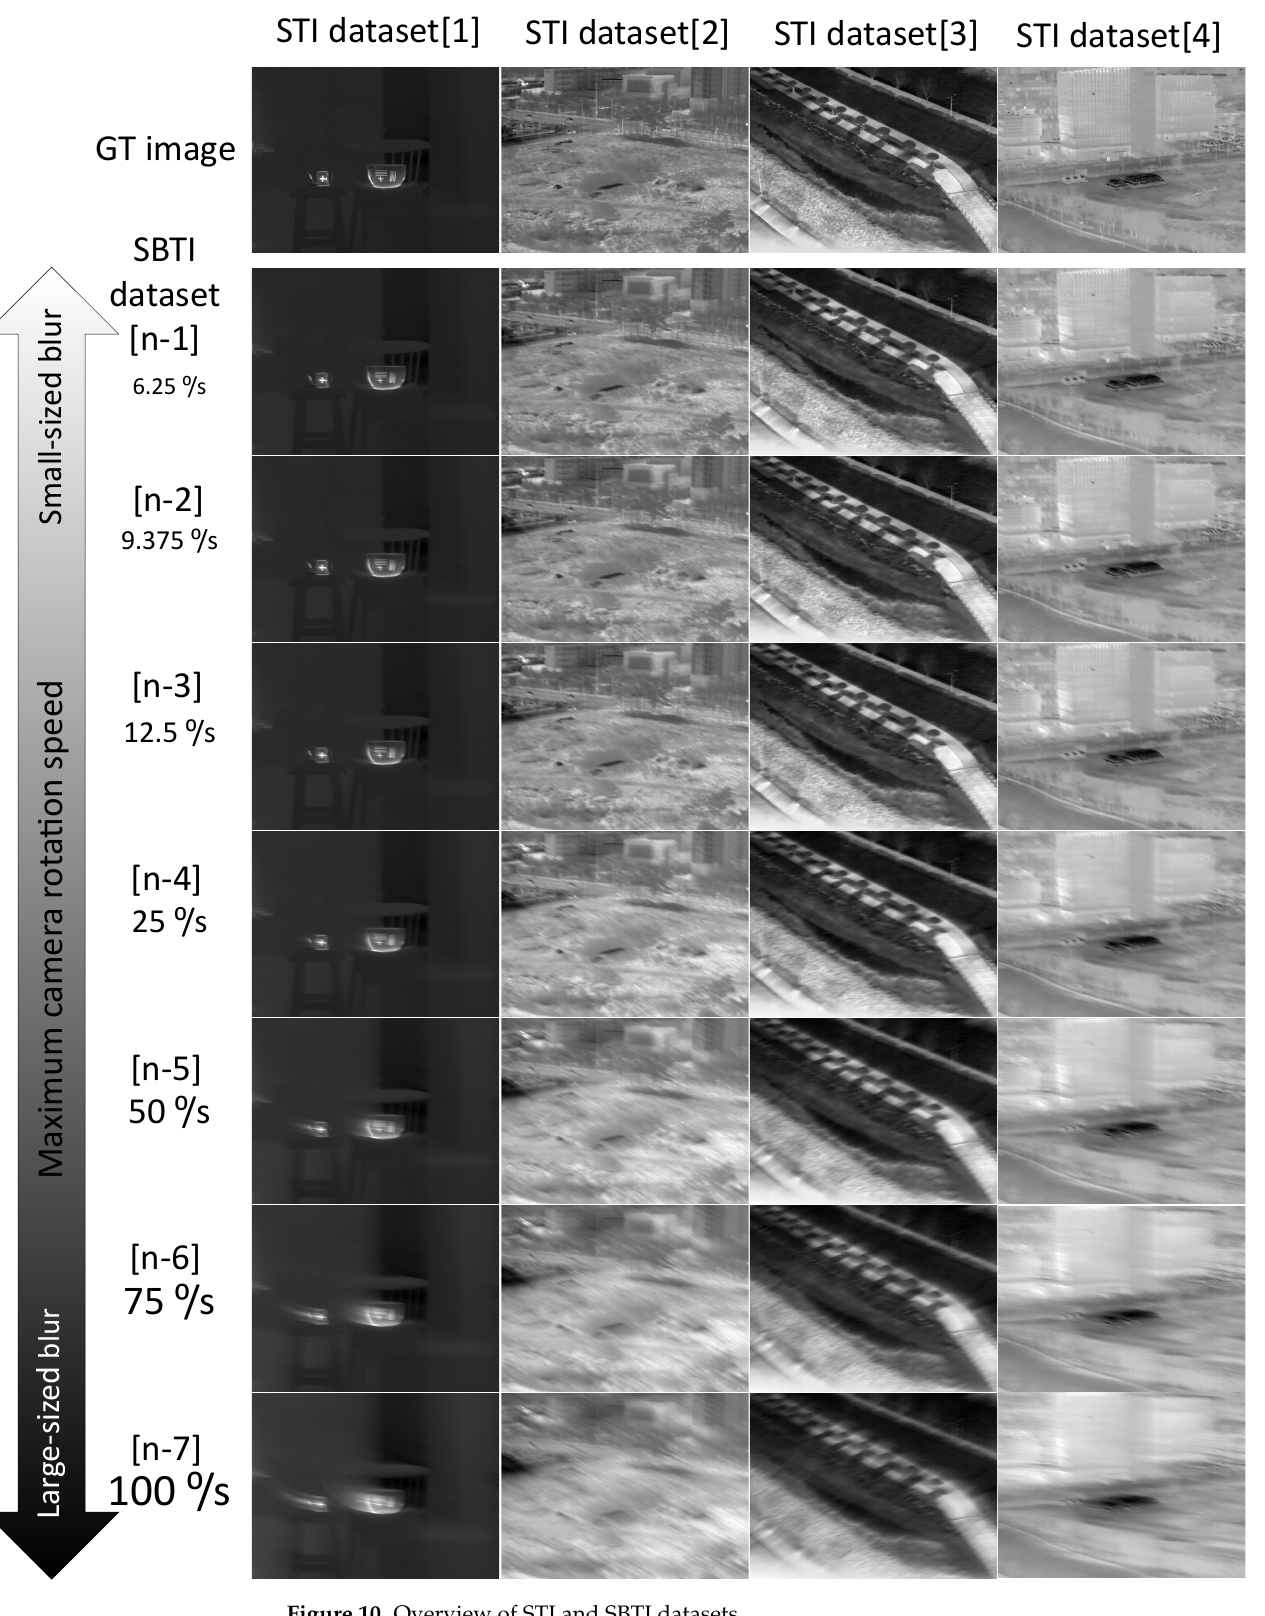
Figure 10. Overview of STI and SBTI